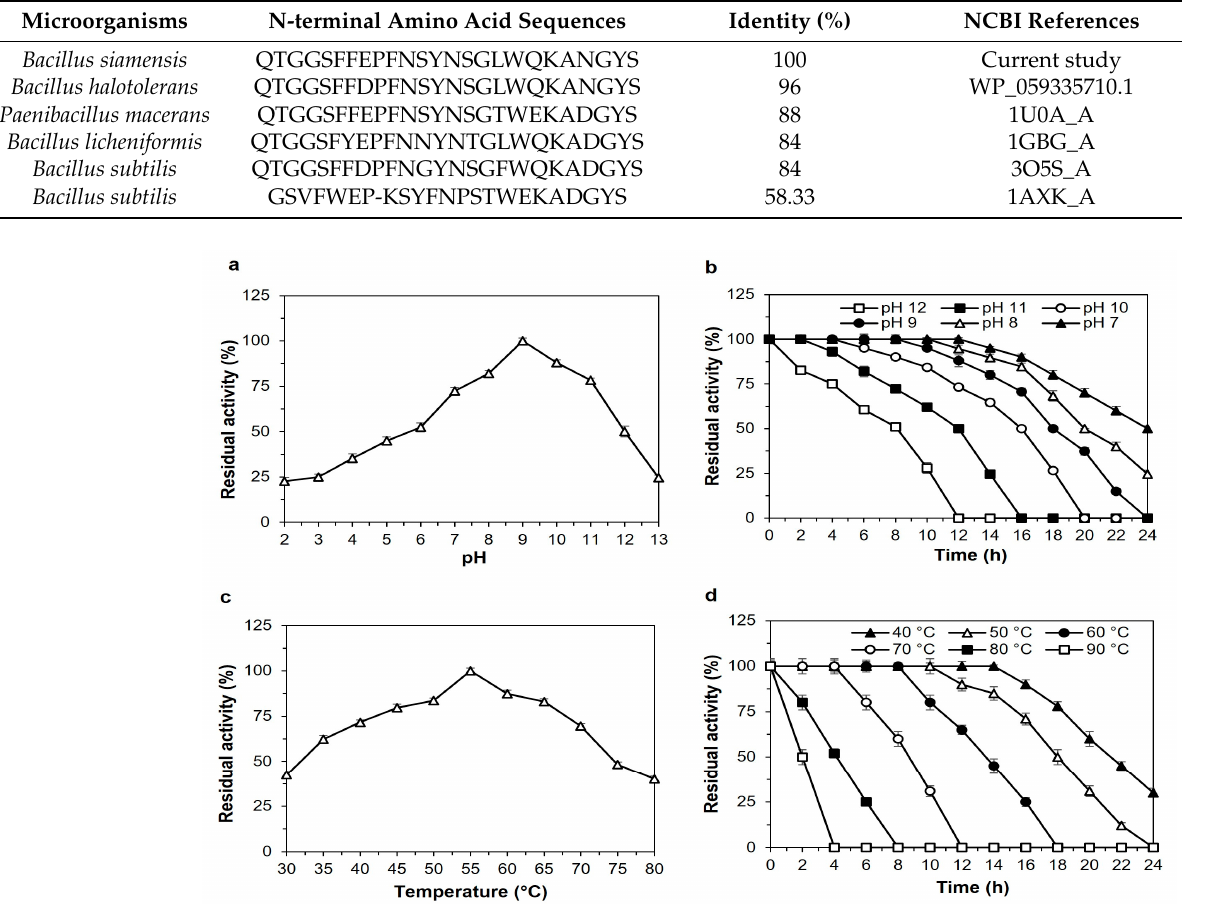
Figure 3. Effect of pH on the ( a ) activity and ( b ) stability of purified protease SH21 from Bacillus siamensis strain CSB55. To check the effect of pH on purified SH21, enzyme assay was carried out using different pH ranges (2–13.0) at 55 °C. The enzyme activity at pH 9.0 was taken as 100%. Effects of ( c ) thermoactivity and ( d ) thermostability on purified SH21. To determine thermoactivity, enzyme SH21 was incubated at different temperatures ranging from 30 to 80 °C with optimum pH (9.0), while thermostability was evaluated at various temperatures ranging from 40 to 90 °C for 24 h at 2 h intervals. Non-heated enzyme activity was considered 100%. Each result presents the mean of three separate experiments (±) standard deviation.